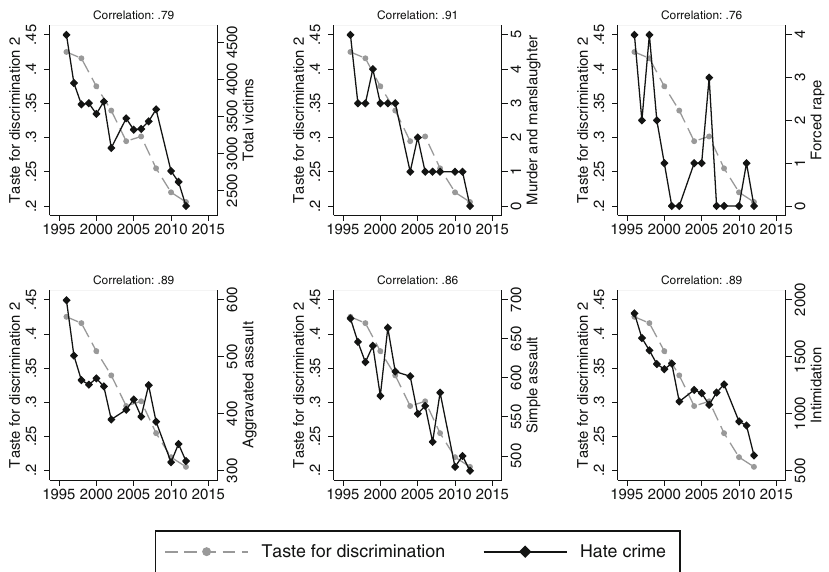
for discrimination